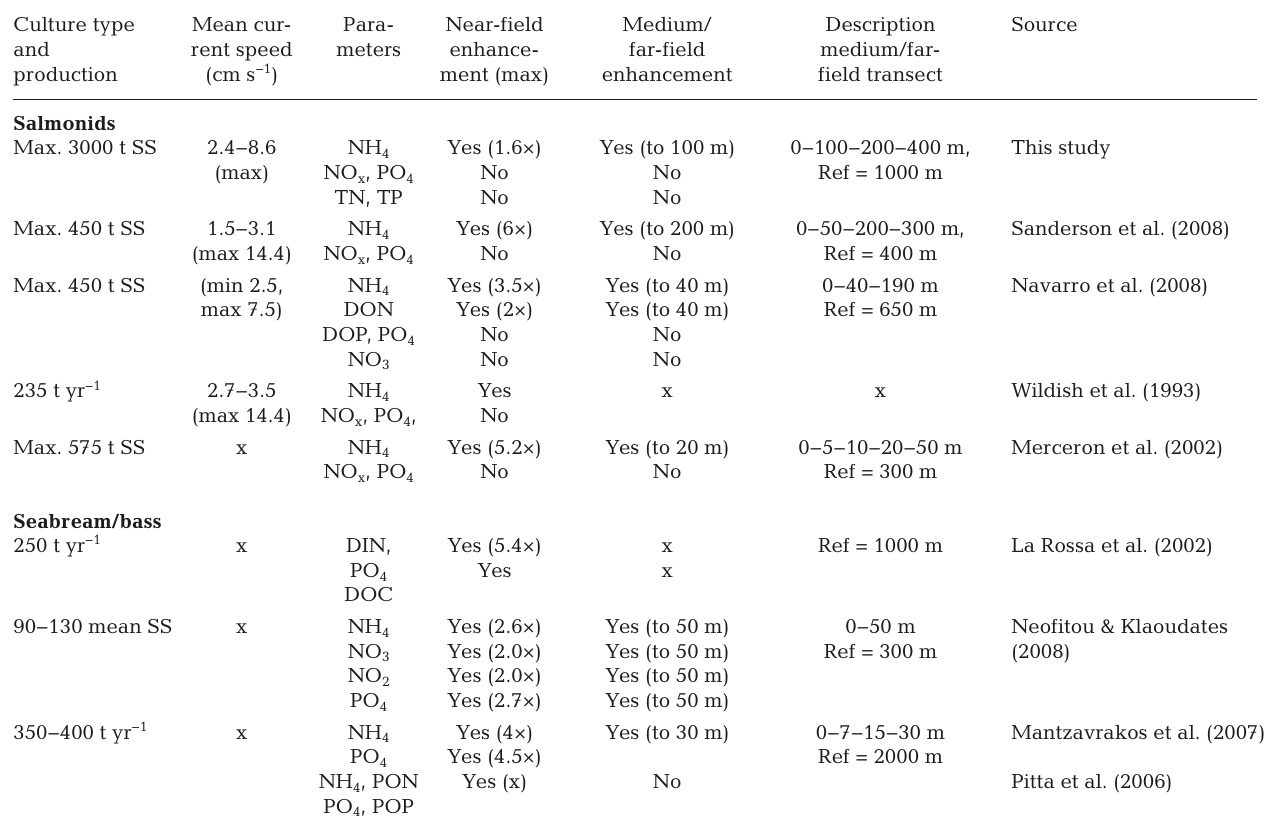
Table 2. Review of nutrient enhancement in the near-field (next to cages) and along a transect away from fish cages (medium to far- field) for the 2 main cage culture types. SS: standing stock, TN: total nitrogen, TP: total phosphorus, DON: dissolved organic nitrogen, DOP: dissolved organic phosphorus, DIN: dissolved inorganic nitrogen, DOC: dissolved organic carbon, POP: particulate organic phosphorus, x: values were not reported, Ref = distance to nearest reference